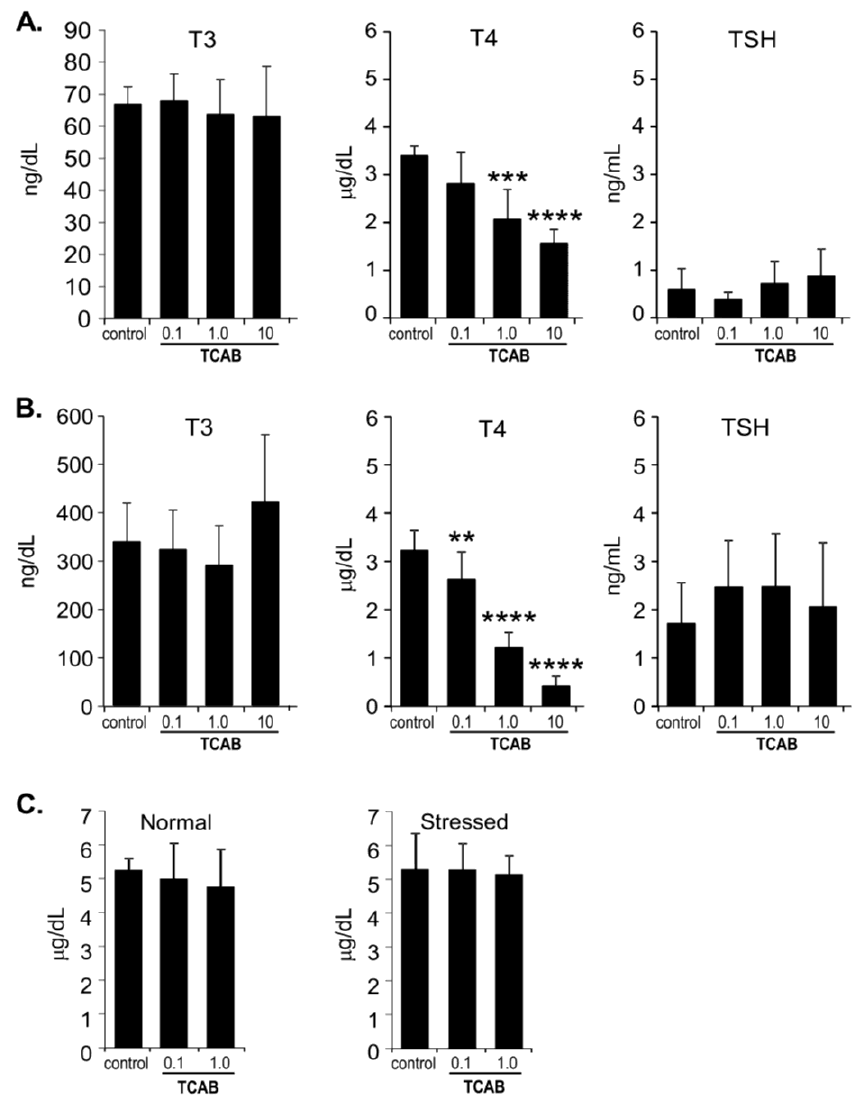
Figure 2. Serum T3, T4, and TSH Levels. Serum T3 (ng/dL), T4 (μg/dL) and thyroid stimulating hormone (TSH) (ng/mL) levels in ( A ) dams at post-natal day (PND)4 ( n = 5, 5, 6, 14, respectively for dose); ( B ) male offspring at PND21 ( n = 7–9) and ( C ) T4 levels in adult male offspring ( n = 10) under normal conditions or following of restraint-stress. Data represents mean ± SEM. ** p < 0.01; *** p < 0.001; **** p < 0.0001 relative to